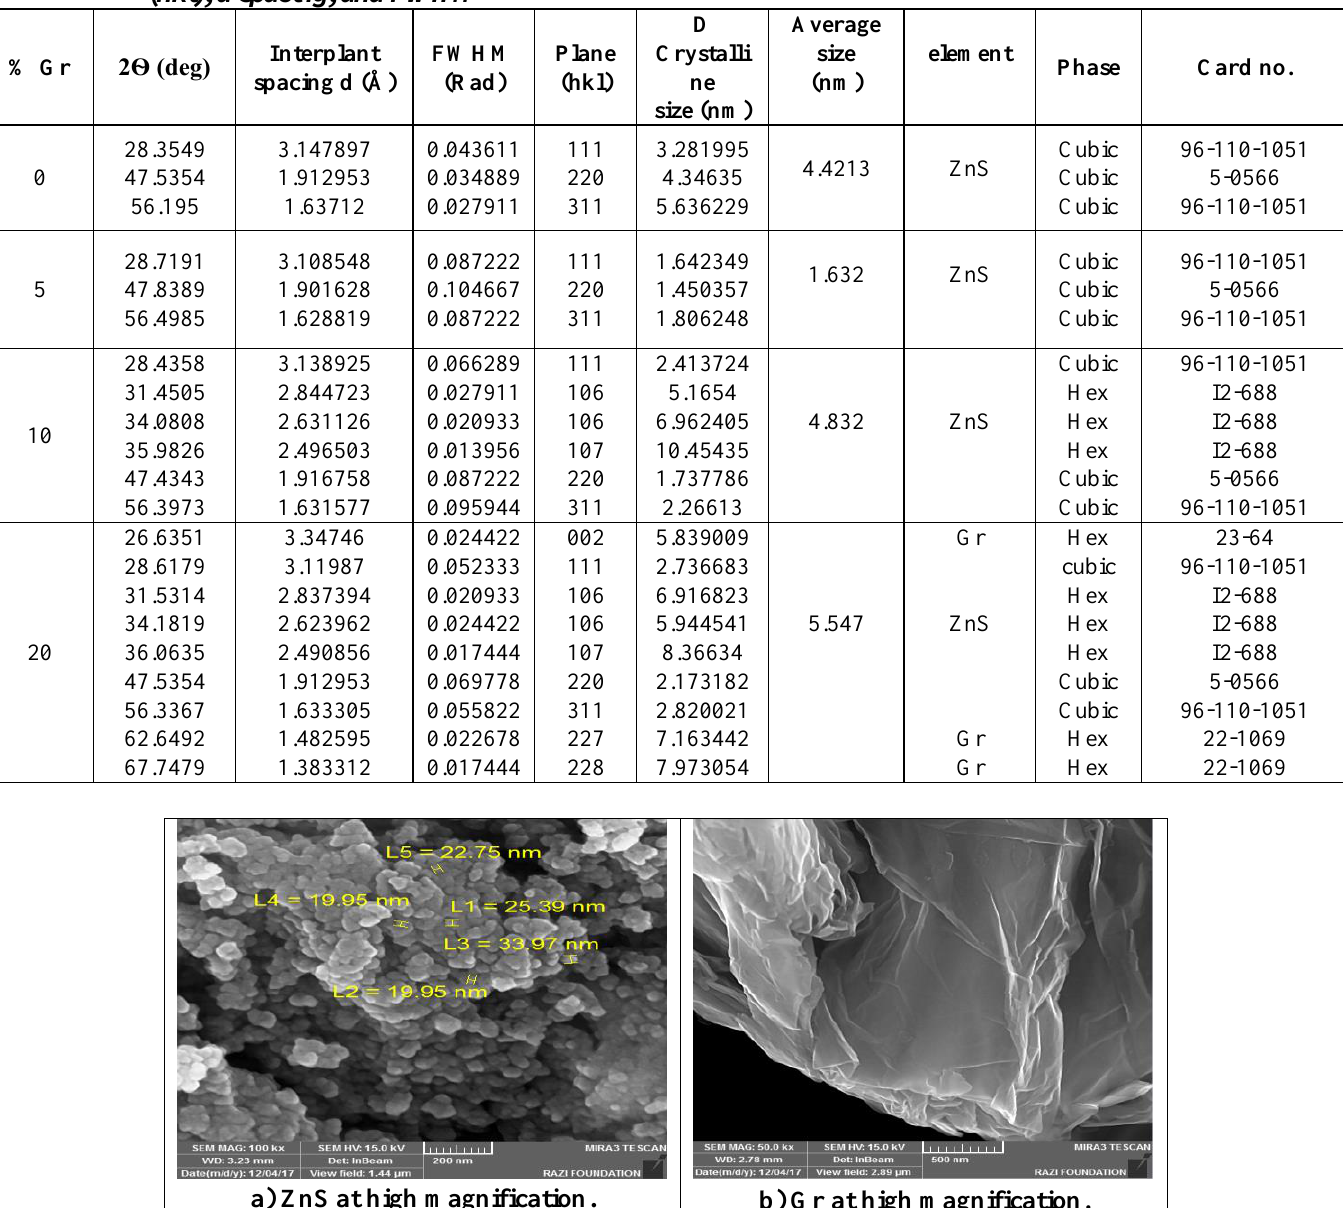
Table 1: Structural parameters of ZnS-Gr nanocomposite which are diffraction angle (2θ), (hkl), d-spacing, and FWHM % Gr